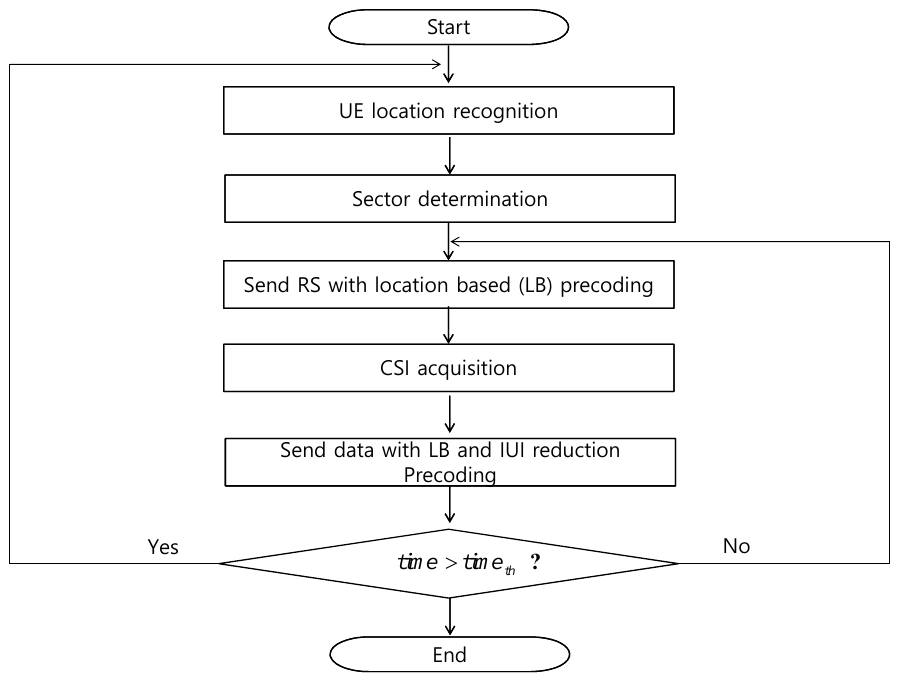
Figure 6. An example of using the grouping resource reuse (BGRR)